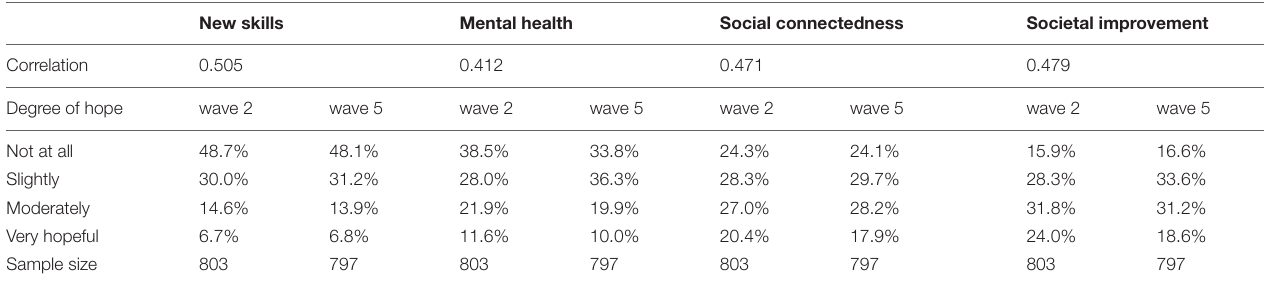
TABLE 2 | Hope-optimism item distributions for waves 2 and 5.